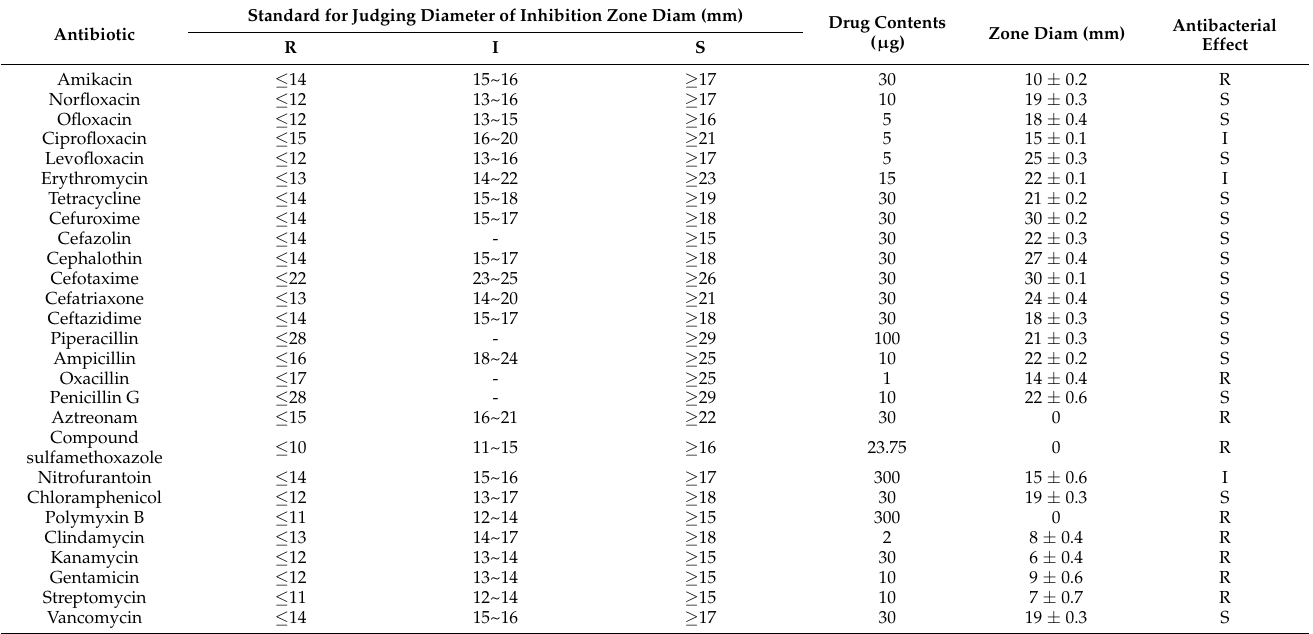
Table A1. E. faecium FUA027 antibiotic resistance judgment criteria and test results. Standard for Judging Diameter of Inhibition Zone Diam Antibiotic